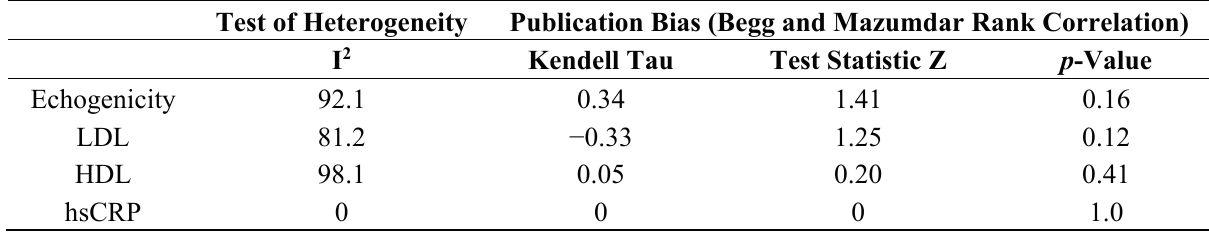
Table 3. Heterogeneity and publication bias